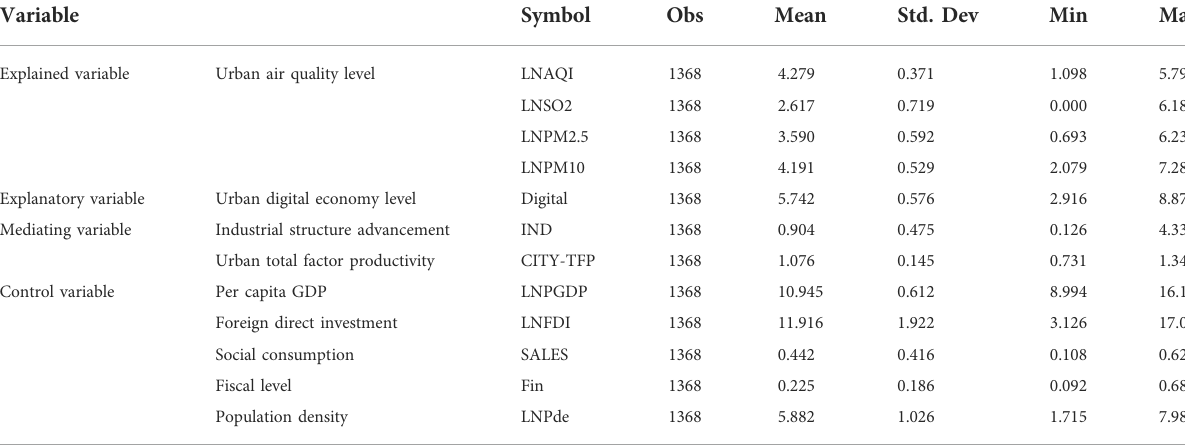
TABLE 1 Descriptive statistics of research variables.